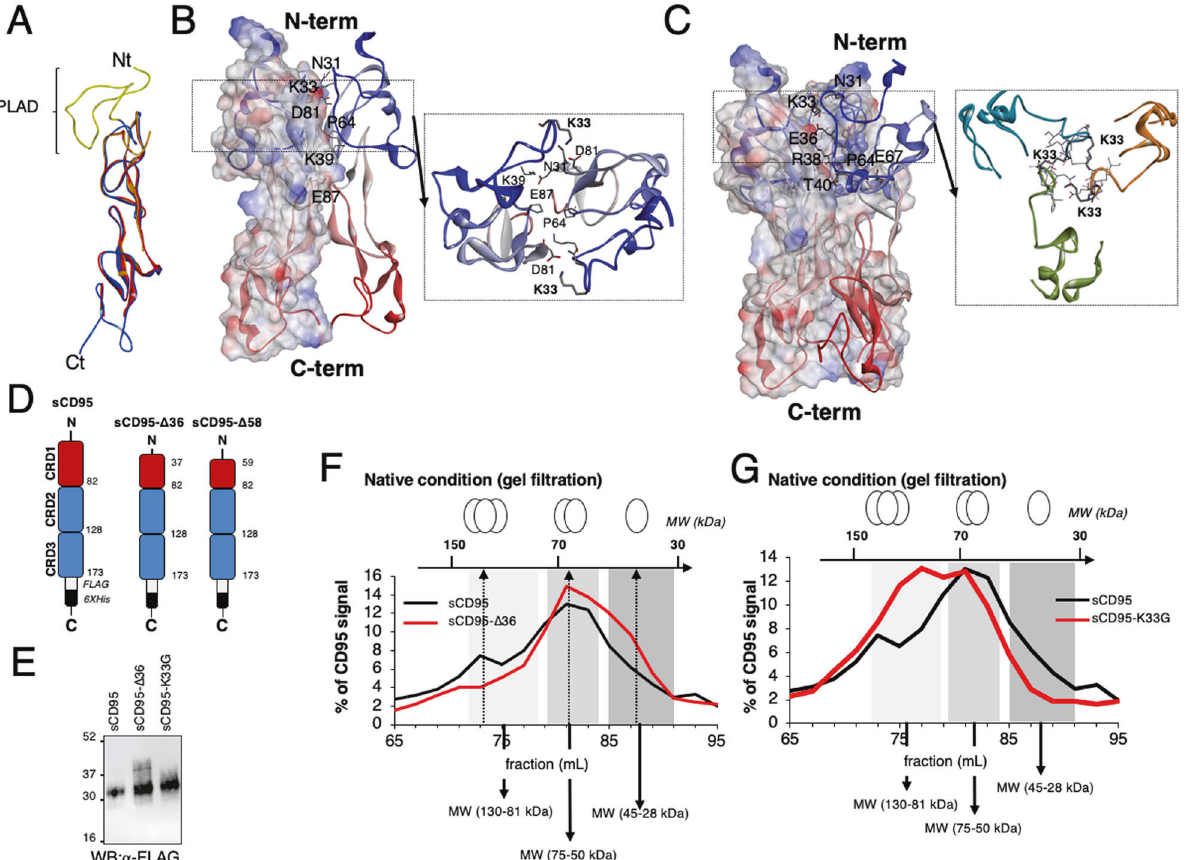
Fig. 4 The N-terminal region of CD95 contributes to receptor aggregation. A Superimposition of the two incomplete crystal structures (PDB:3THM in orange and PDB:3TJE in red). Using these structures, the complete amino-terminal region from R17 to G51 in PLAD was reconstituted by ab initio modeling and fused to the X-ray CD95 structures (in blue). Long molecular dynamics experiments (2µs) were fi nally performed to equilibrate the model. B The 3D organization of the CD95 dimeric model was generated by protein-protein docking of the protomer using SymmDock, with an imposed 2-fold symmetry. Most important amino acid involved in the interaction are depicted. C The 3D organization of the CD95 trimeric model was generated by protein-protein docking of the protomer using SymmDock, with an imposed 3-fold symmetry. D Indicated soluble CD95 constructs were expressed in HEK/293 T cells. E In denaturing and reducing conditions, the molecular weights of the soluble forms of full-length extracellular domain of CD95 (sCD95), Δ 36 truncated counterpart (sCD95- Δ 36) and K33G mutant (sCD95-K33G) were assessed by western blot. F In native condition, supernatants of the different sCD95-secreting HEK/293 T cells were resolved by gel fi ltration and, the quantity of sCD95 present in each fraction was measured by ELISA. The molecular weights of full-length extracellular domain of CD95 (sCD95) and sCD95- Δ 36 constructs were assessed using native molecular markers. For each fraction, the percentage of dosed CD95 was depicted. G In native condition, the molecular weights of full-length extracellular domain of CD95 (sCD95) (also depicted in F ) and sCD95-K33G constructs were assessed by gel fi ltration as described in ( F CD95 can be detected with 6A9 and 10E4 antibodies as compared to those obtained with 9C11 and 4F10 mAbs (Fig. 3E).